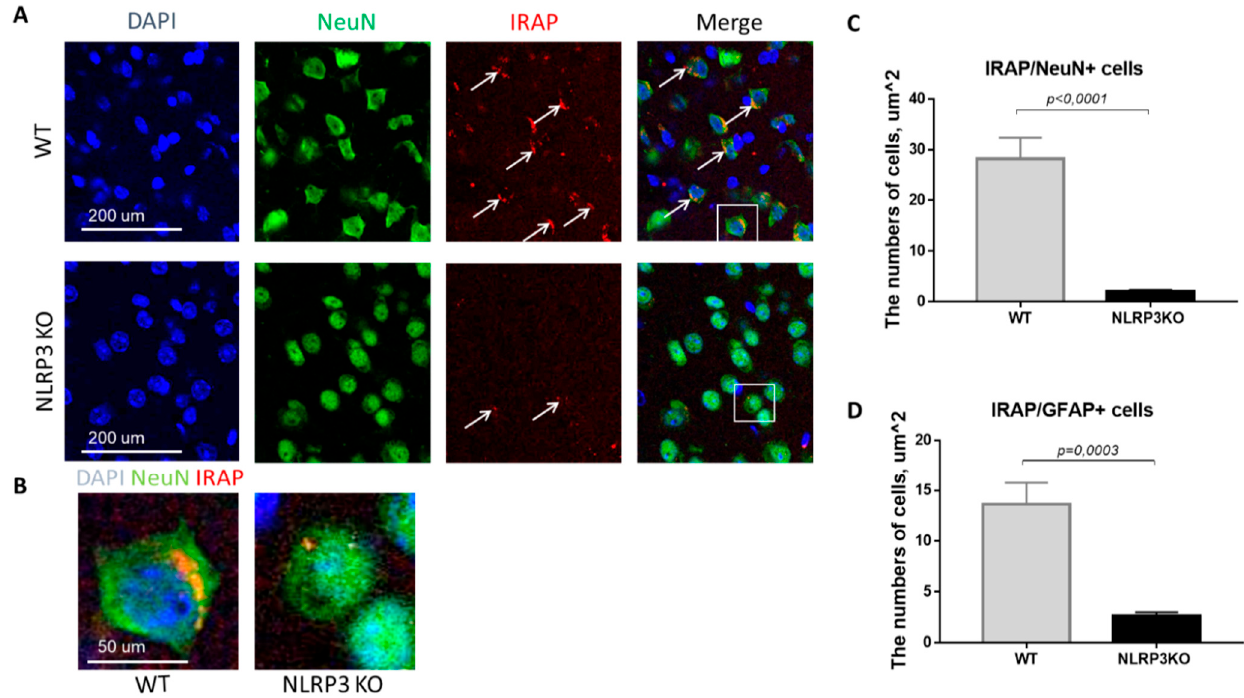
Figure 9. Expression of IRAP in mature neurons and astrocytes of the basolateral amygdala in mice. ( A ) Triple immunofluo- rescent staining: cell nuclei—DAPI (blue), NeuN (green), IRAP (red), signal overlay (Merge). Scale Bar—200 µ m. ( B ) Overlay of signals: cell nuclei DAPI (blue), NeuN (green), IRAP (red). Scale Bar—100 µ m. ( C ) Number of IRAP/NeuN + cells. ( D ) Number of IRAP/GFAP + cells. WT—control mice group, NLRP3KO—NLRP3 knockout mice. Data are presented as a mean ± SEM.